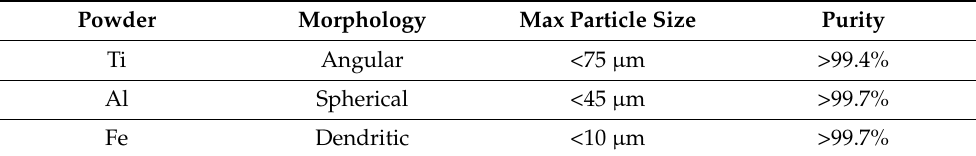
Table 1. Features of the starting powders as per suppliers’